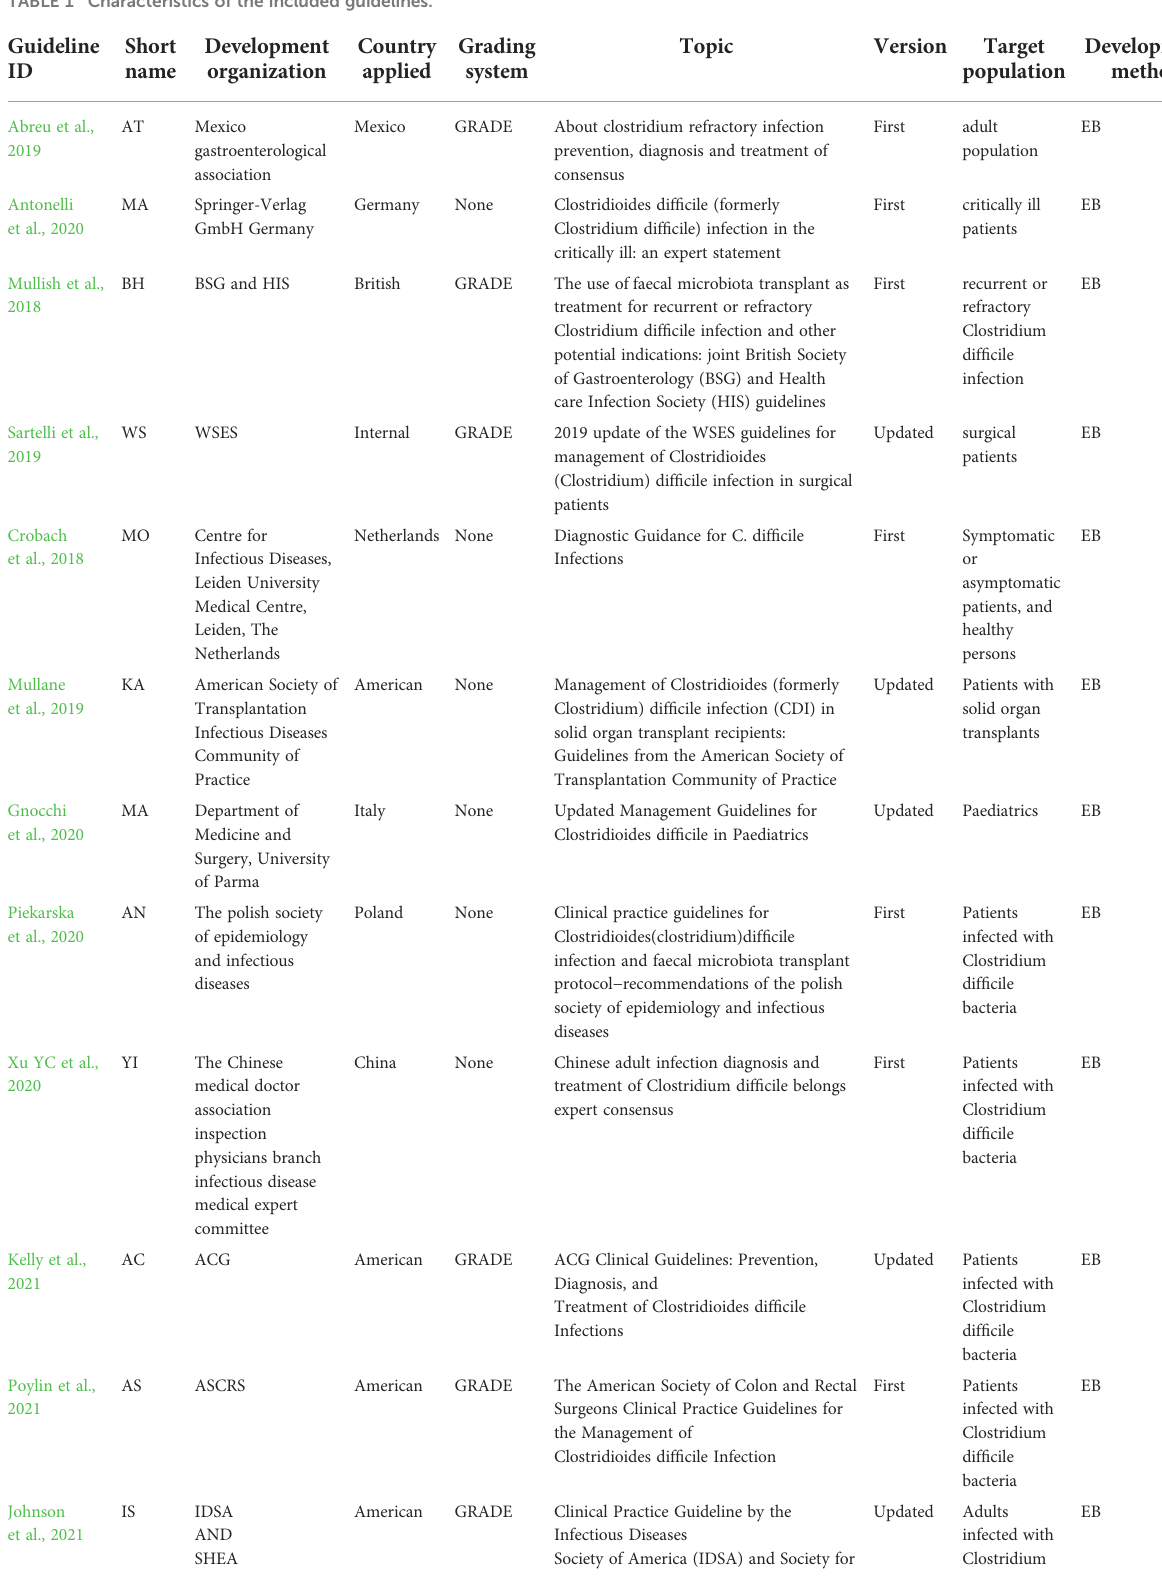
TABLE 1 Characteristics of the included